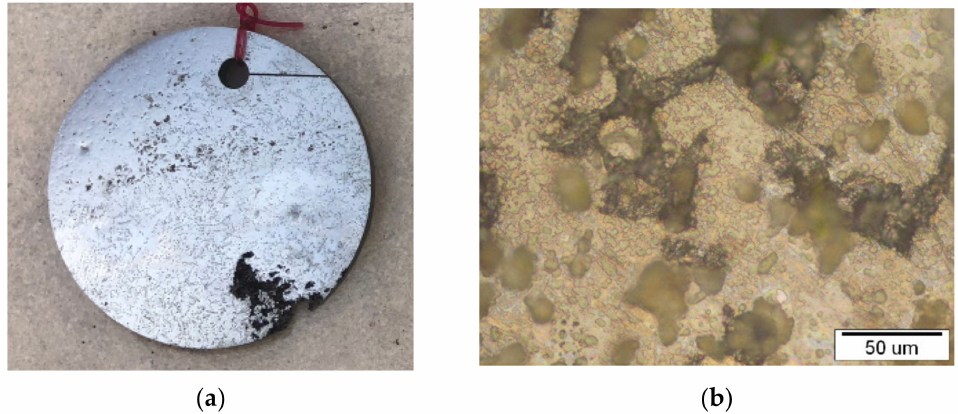
Figure 4. NiTi disc after 6 months in a tidal zone: ( a ) presentation of a macro view and ( b ) representa- tive optical microstructure.